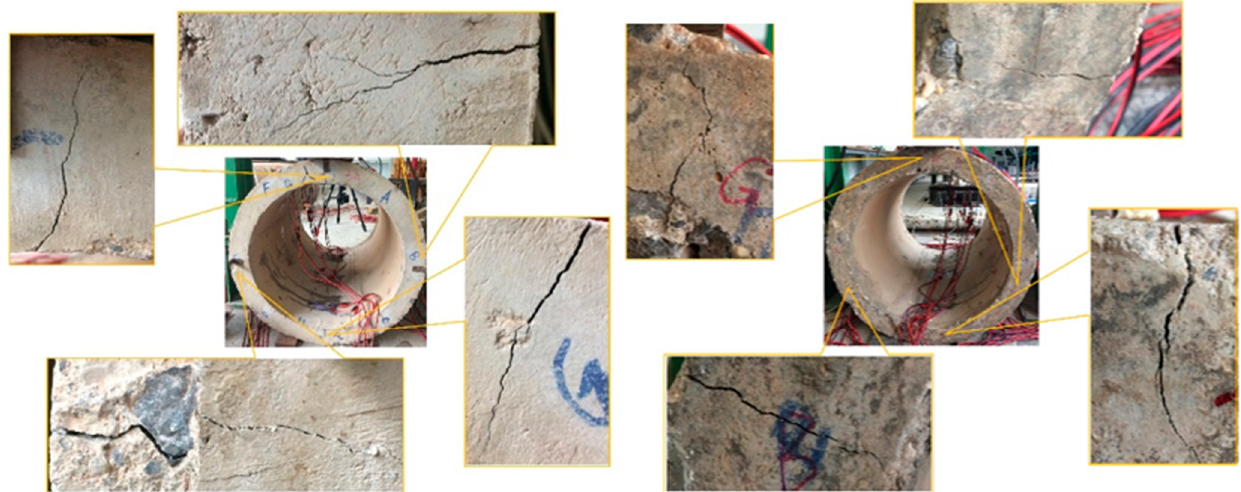
Figure 14. Crack distribution at the end of test piece No. 3.